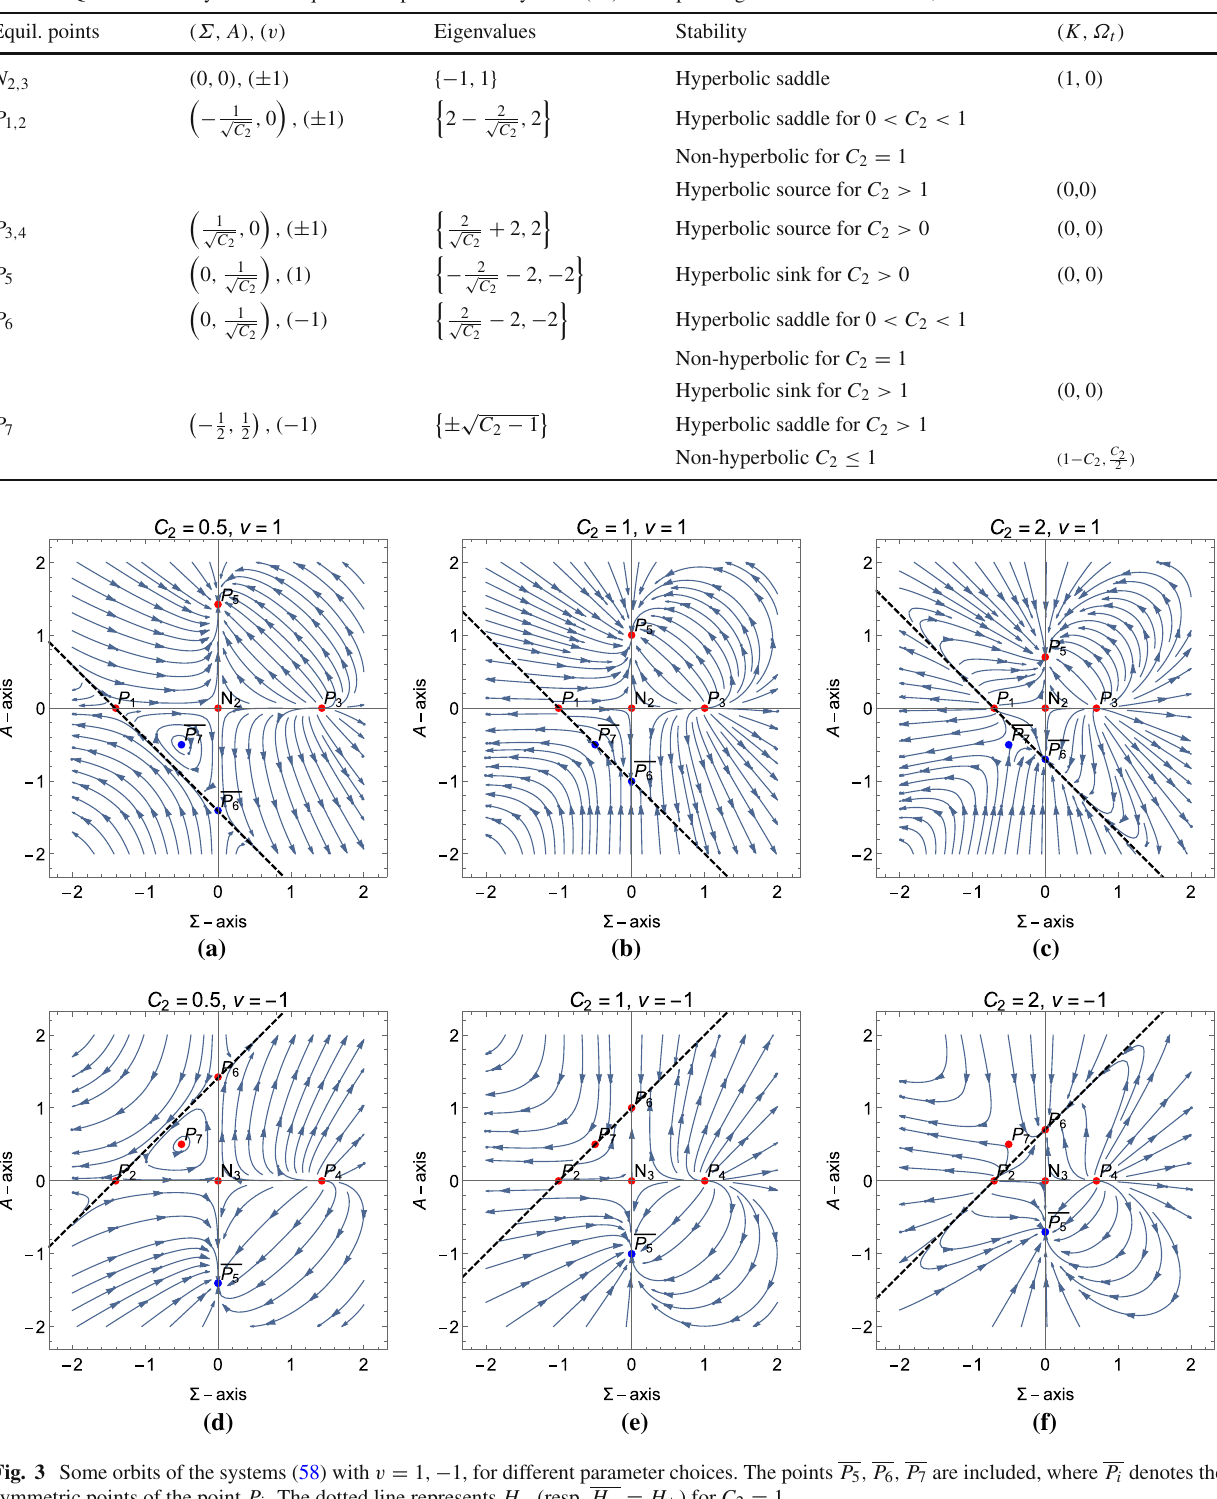
Table 1 Qualitative analysis of the equilibrium points of the systems (58) corresponding to extreme tilt: v = 1 , − 1 Equil. points